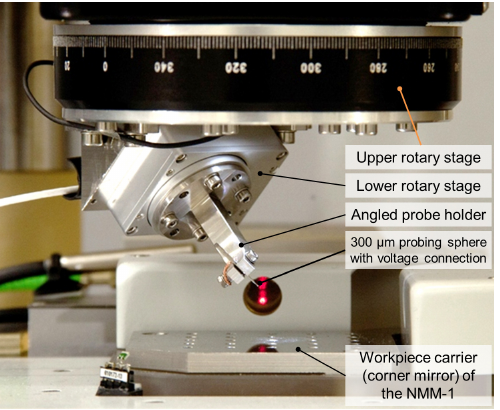
Figure 8. Kinematic chain installed into the NMM-1 with the elec- trical near-field